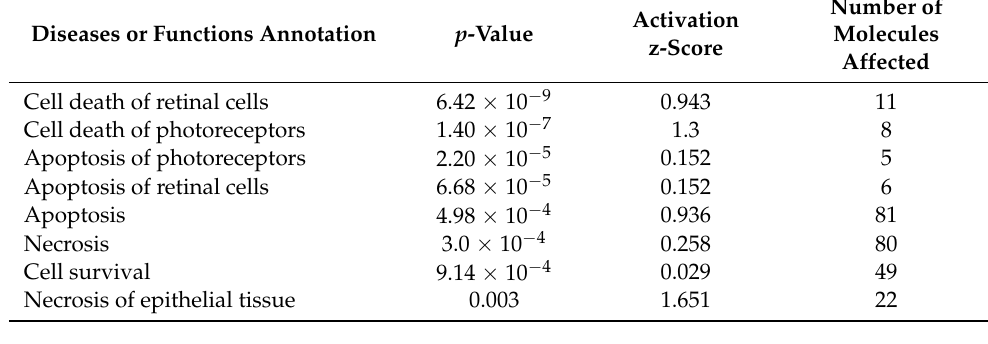
Table 4. Cell death and survival.